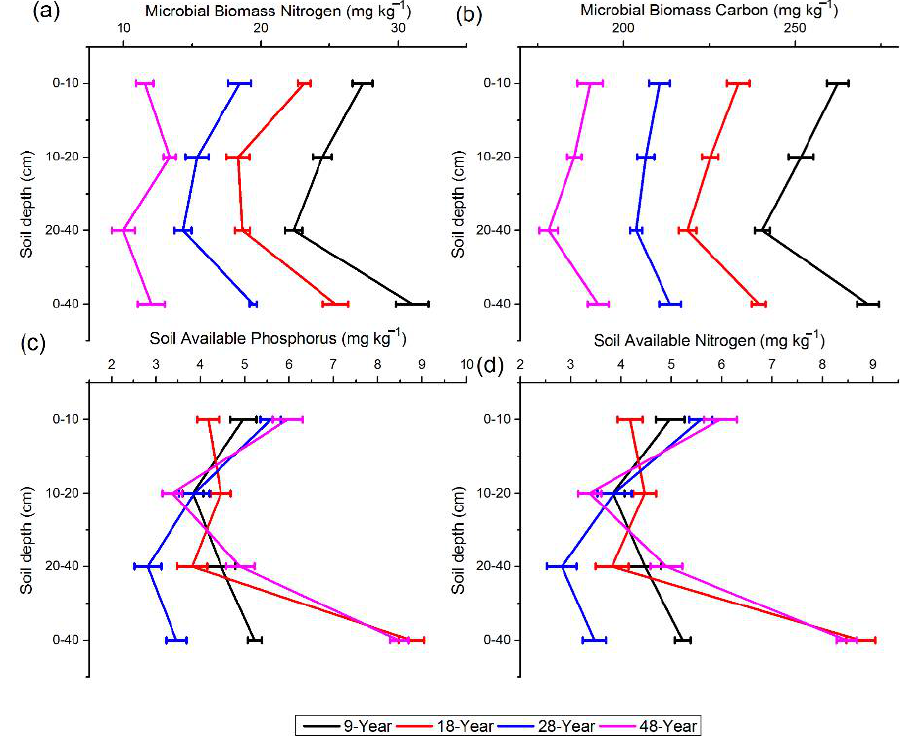
Figure 2. Soil properties in soil layer of P. massoniana chronosequence. Lines represent mean value with three replicates ( n = 3; p < 0.05). Figures ( a – d ) represents MBN, MBC, SAP, SAN in different soil depths, repectively. Error bars show standard error.